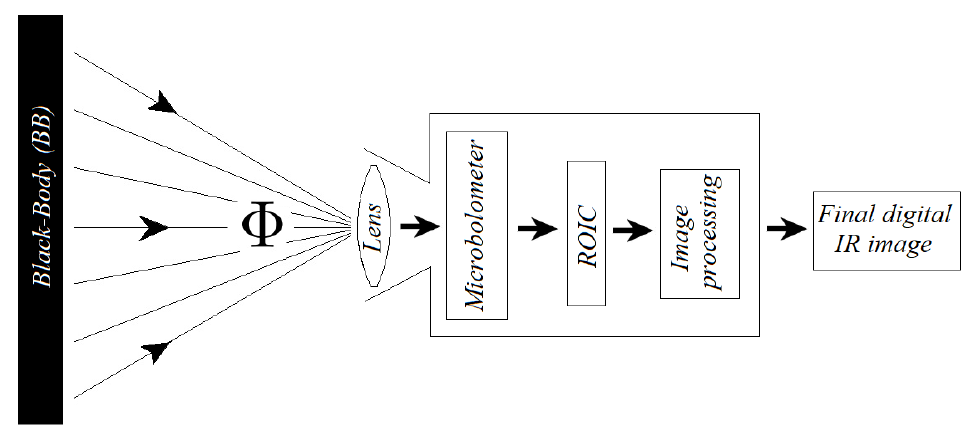
Figure 1. A system where an IR sensor with a lens receives radiant flux Φ from the BB. The radiant flux emitted by the unit surface area dA 1 is characterized by the object radiant exitance: M = Φ 1 / dA 1 [W/m 2 ], while the IR sensor receives irradiance on the unit surface area dA 2 : E = Φ 2 / dA 2 [W/m 2 ], where Φ 1 and Φ 2 denotes the radiated fluxes emitted by the object and received by the sensor. BB has a characteristic radiance L (shown in Figure 2, Left ) that indicates how much of the surface radiated power is received by an optical system observing from a certain viewing angle. In Figure 2, Right , the relationship is illustrated when the power is integrated per unit area in a temperature range (from 300 to 400 K) and an almost linear relationship is represented. The BB radiance L at